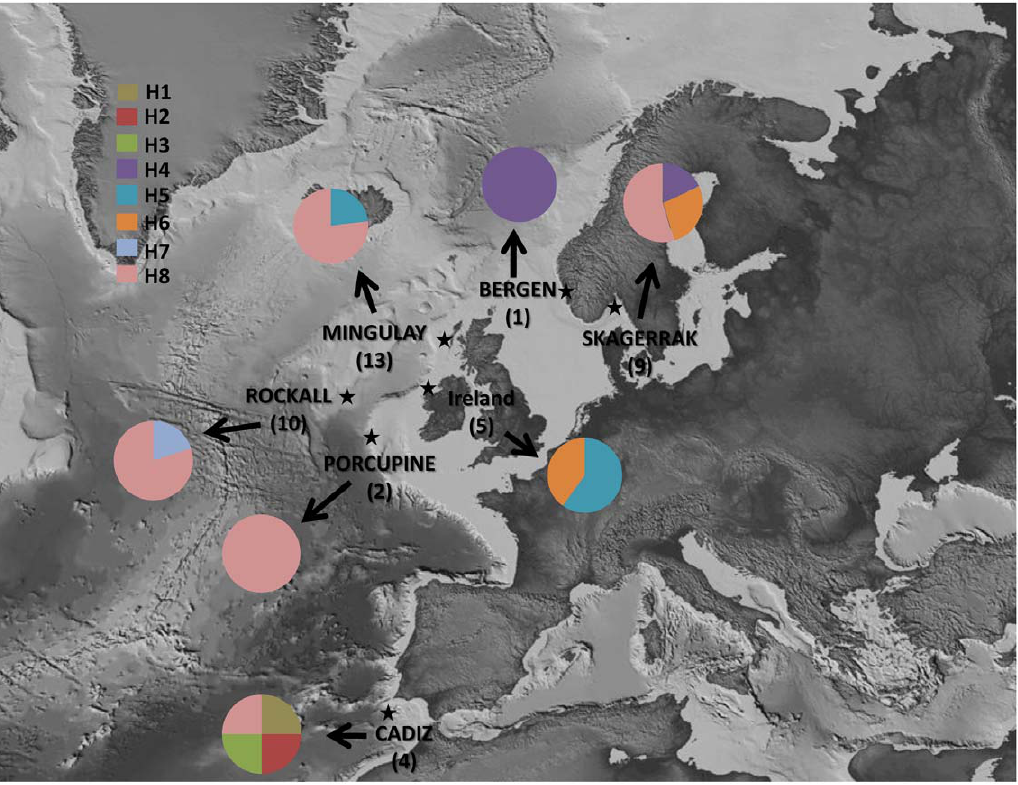
Figure 1. Map showing sampling locations of Plocamionida species (numbers in parenthesis indicate sample sizes) and geographical distribution of ESUs. Map was provided by the project Hotspot Ecosystem Research and Man’s Impact on European Seas (HERMIONE). Sampling location are given in uppercase letters for deep-water samples ( . 50 m) and in lowercase letters for shallow-water samples.